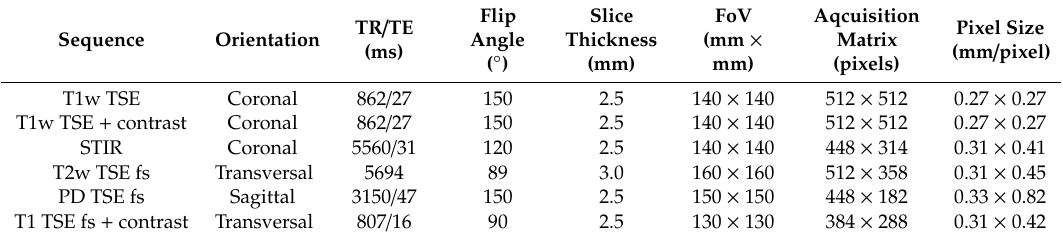
Table 1. Detailed Magnetic Resonance Imaging (MRI) Sequence